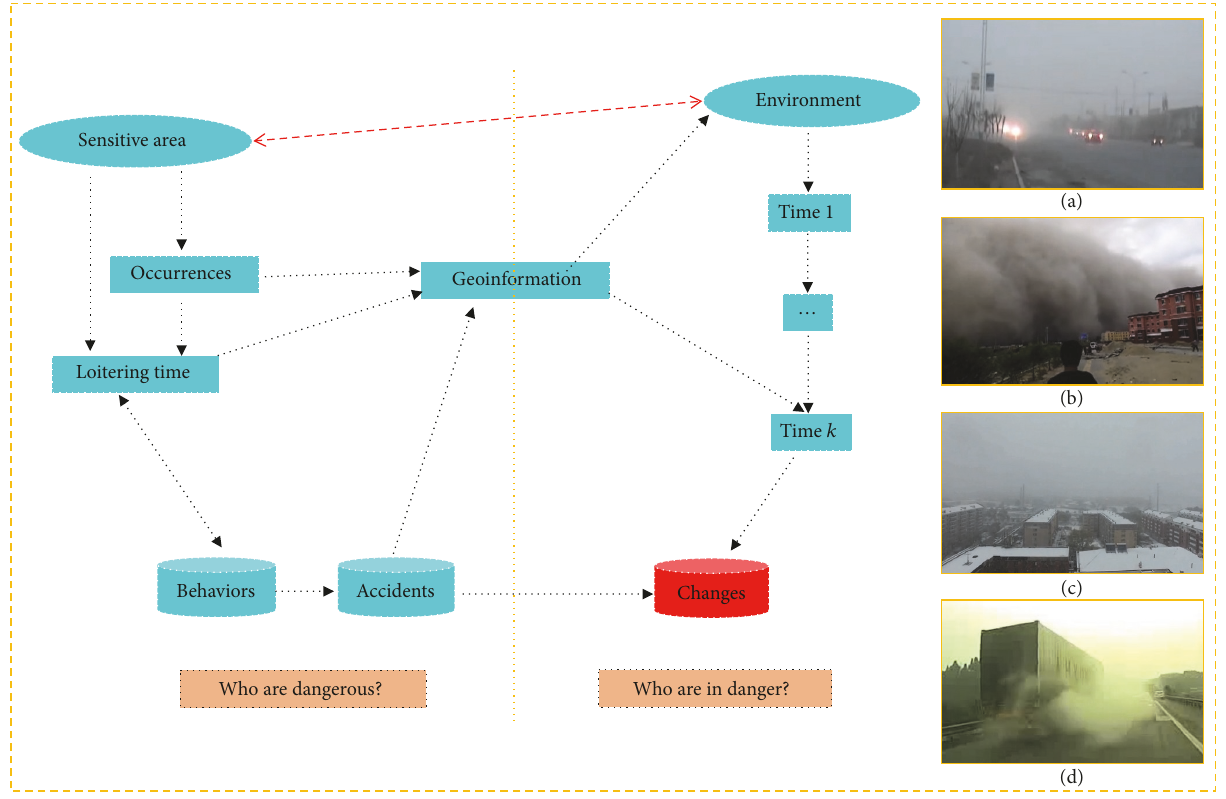
Figure 1: A conceptual framework of precision security with four real scenarios as examples, (a) smog (captured by an android camera), (b) sandstorm (captured by a mobile phone), (c) blizzard (with videos collected from a drone), and (d) truck exhaust (with videos collected by a driving